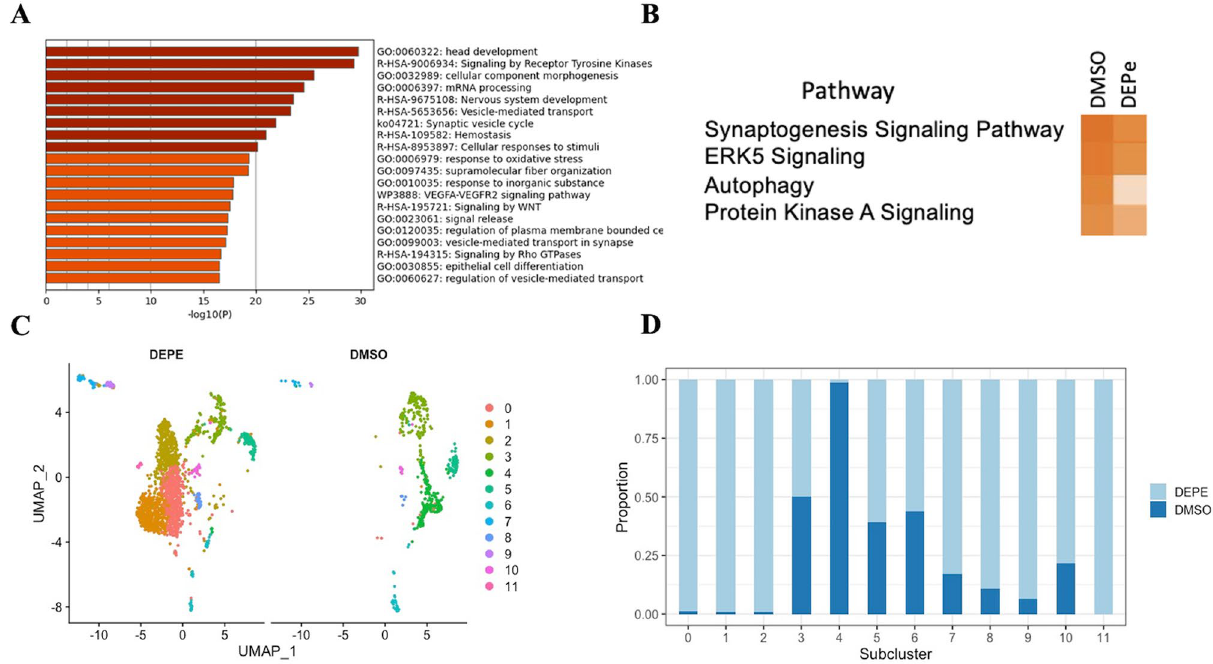
Figure 4. Neuronal cluster 2 analysis with and without DEPe exposure. ( A ) The top enriched biological processes in control neurons. ( B ) Ingenuity Pathways Analysis (IPA) summary. Darker orange denotes more activated pathways (z-score > 2; p-value < 0.05). ( C ) UMAP plots of DEPe and DMSO treated neuronal subclusters. ( D ) Subclustered neuronal distribution with DEPe and DMSO